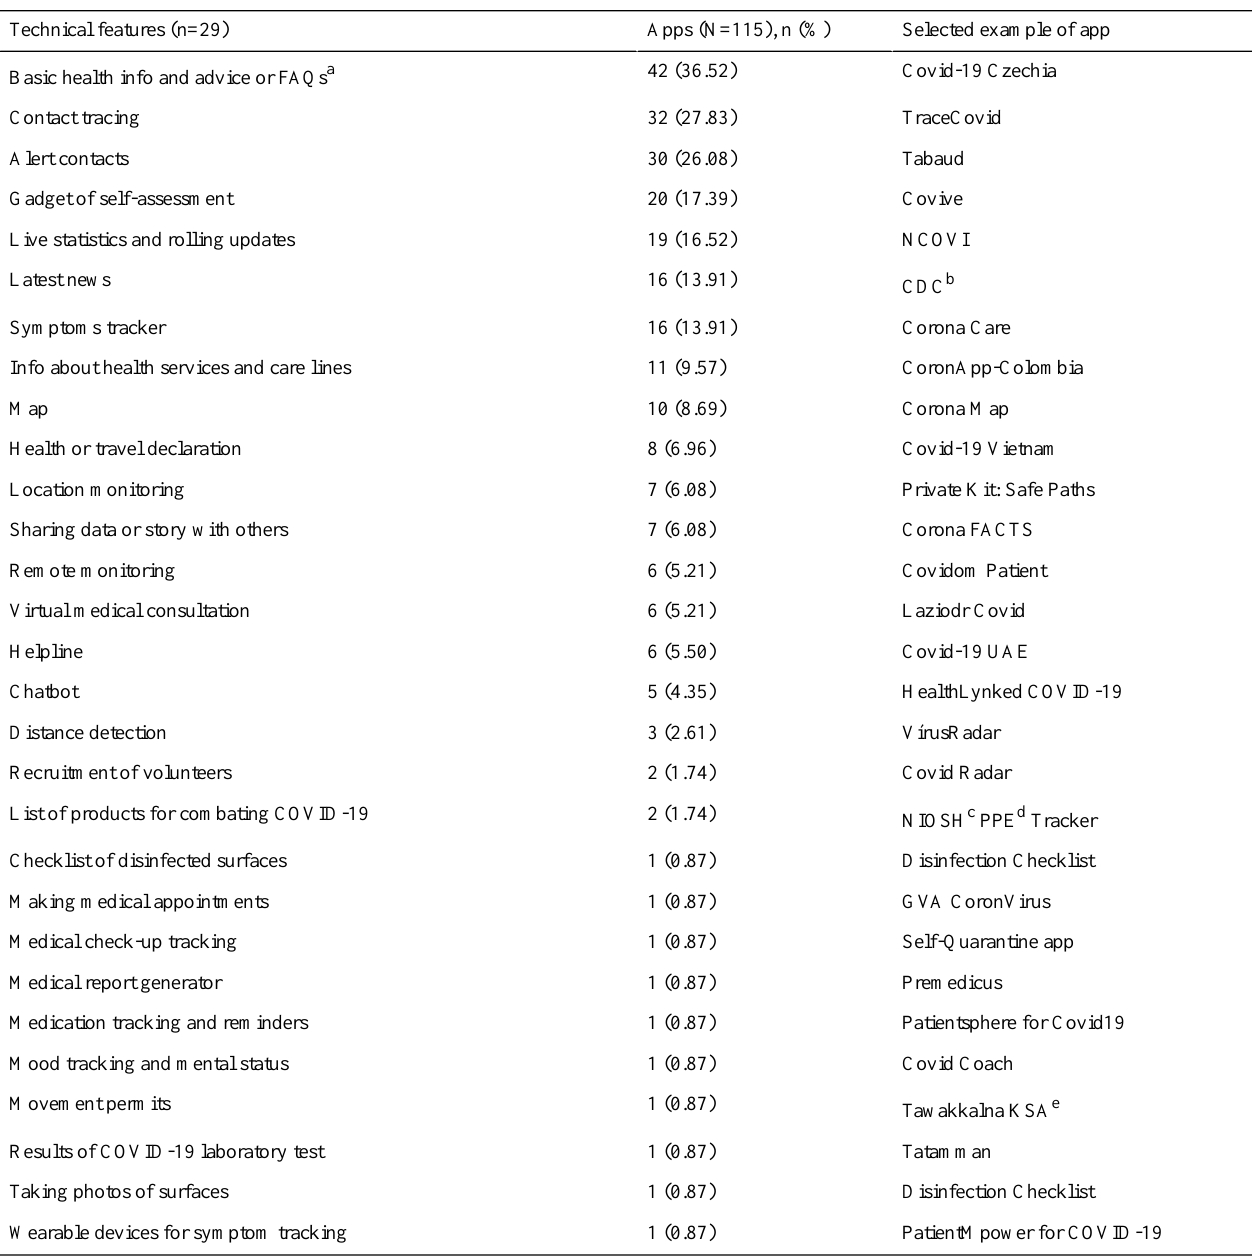
Table 3. Summary of the apps’technical features with